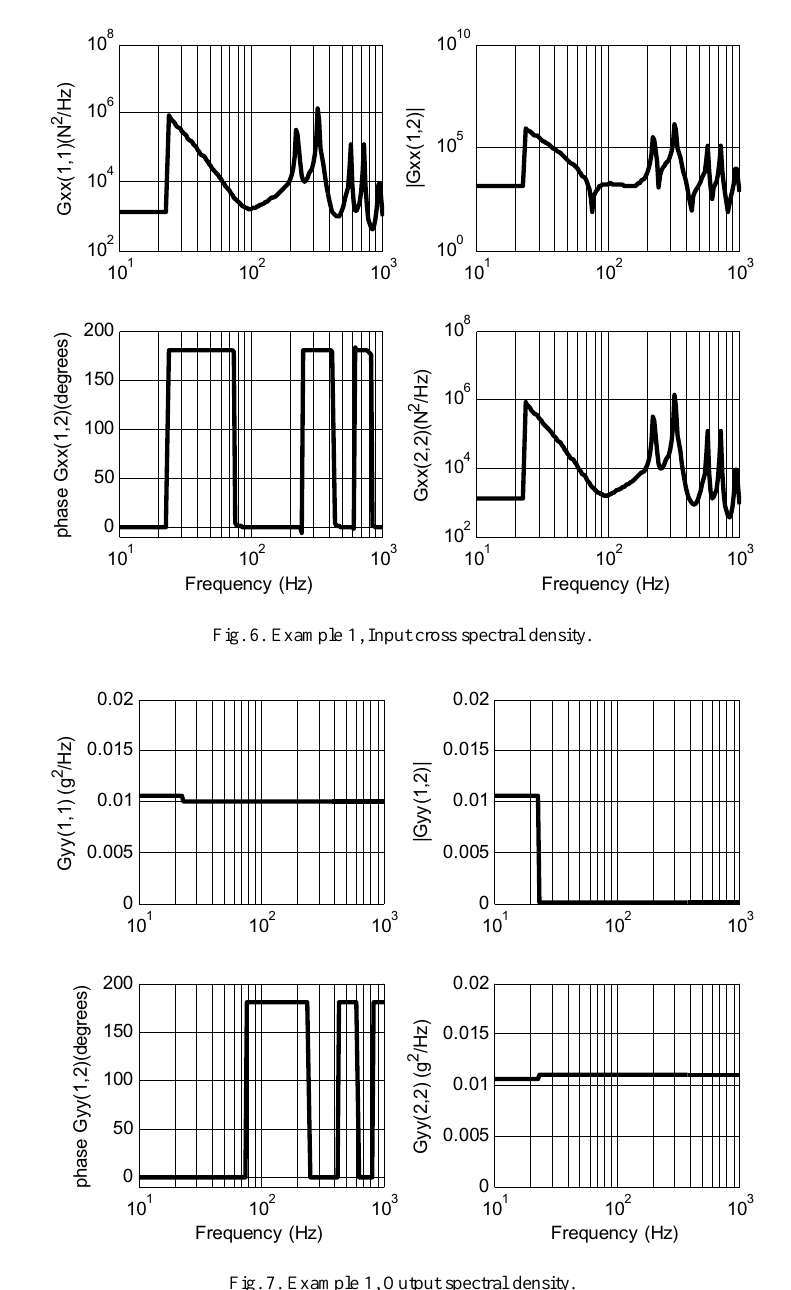
Fig. 7. Example 1, Output spectral